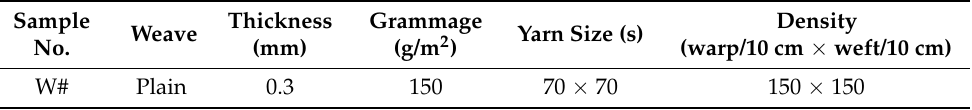
Table 2. Basic parameters of polyester